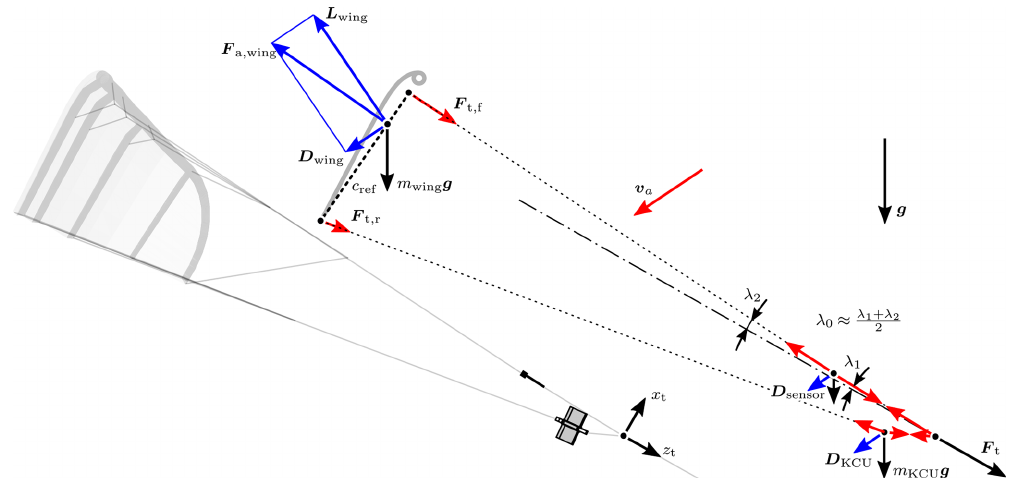
Figure 11. Fully powered kite ( a ) and simplified mechanical model of the kite system ( b ), including the wing, measurement setup and KCU, showing external forces (black: gravitational forces and tether force at the bridle point, blue: aerodynamic forces) and internal forces (red: bridle line forces) to calculate the bridle line angles λ 1 and λ 2 . Depicted is the special case of an upwards-oriented kite with apparent flow velocity and all model forces in the drawing plane. Force vectors are not to